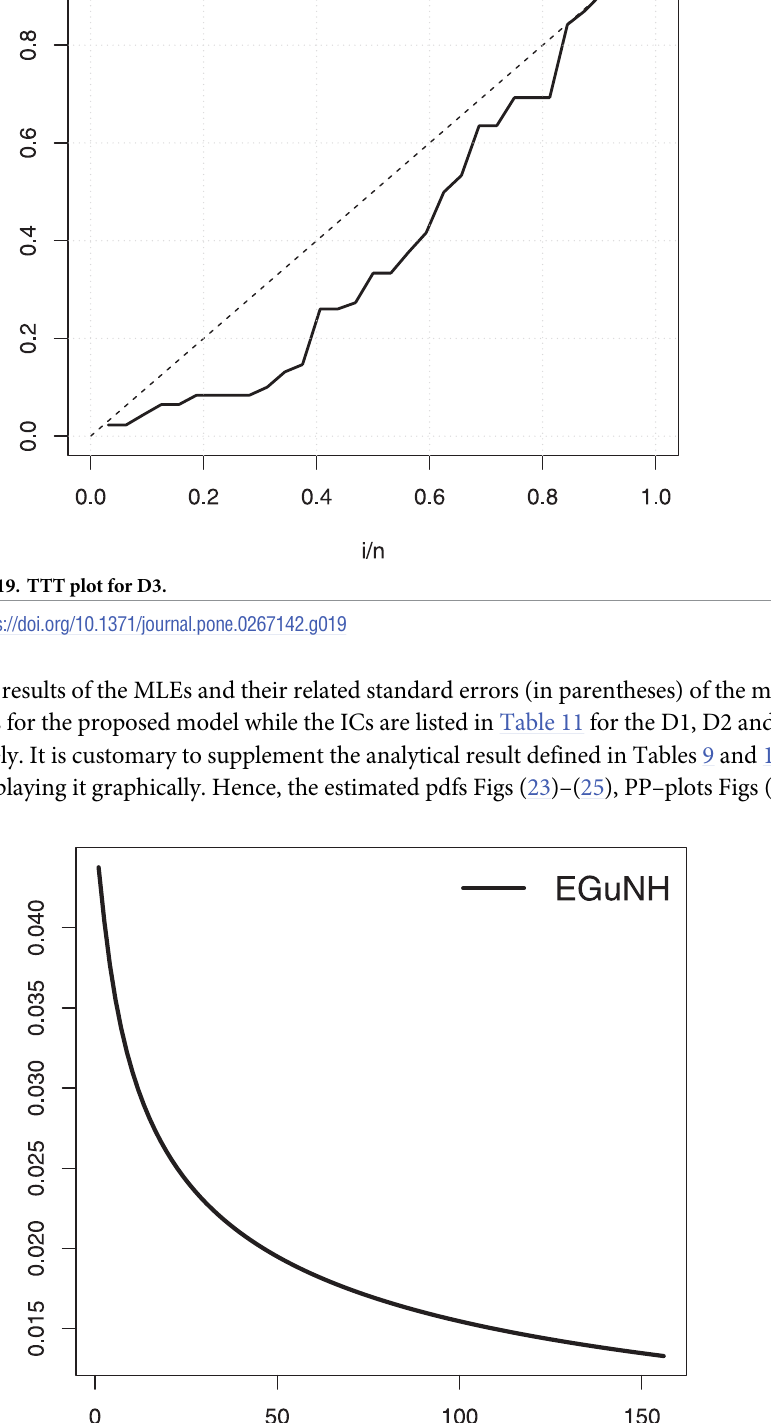
Fig 20. Estimated hrf for